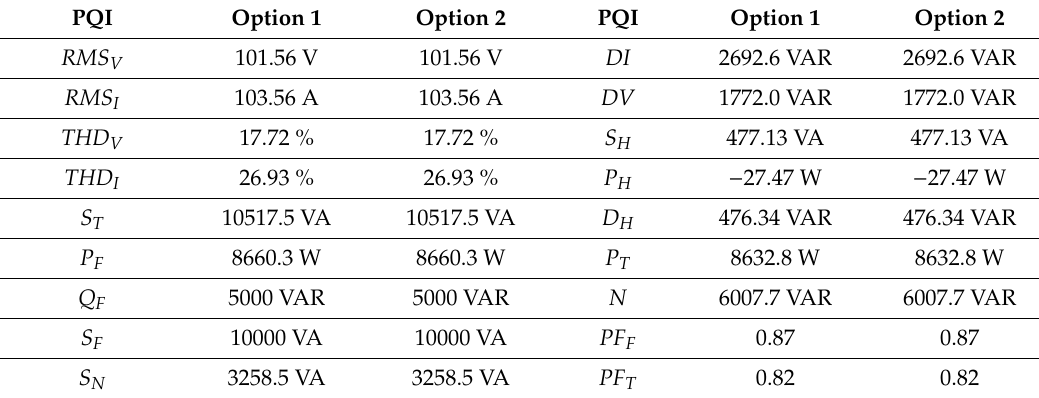
Table 3. Results for the numerical example using either classical formulation or global harmonic parameter (GHP)-based